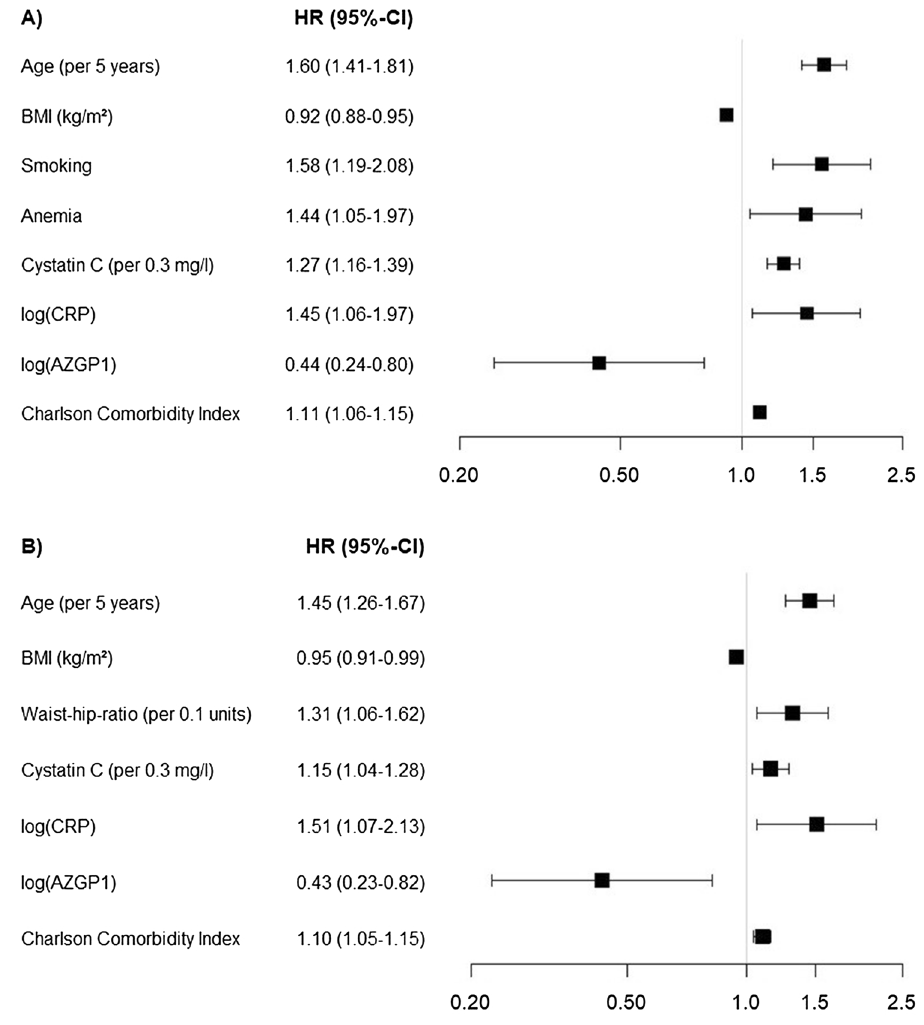
Figure 1. Predictors for (A) death and (B) composite endpoint (endpoint of myocardial infarction, stroke or death) from the multivariable Cox model with stepwise backward selection. BMI body mass index, log natural logarithm, CRP c-reactive protein, HR hazard ratio, CI confidence interval. The figure was produced with IBM SPSS Statistics version 25.0 (https:// www. ibm. com/ de- de/ analy tics/ spss- stati stics- softw are) and R version 4.0.0 (https:// www.R- proje ct.